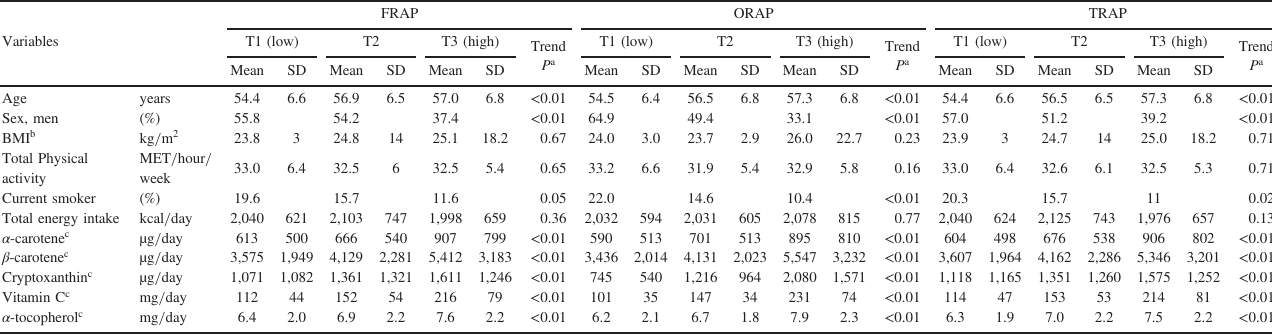
Table 2. Characteristics of study subjects by tertile of dietary NEAC estimated in the FFQ FRAP ORAP TRAP Variables